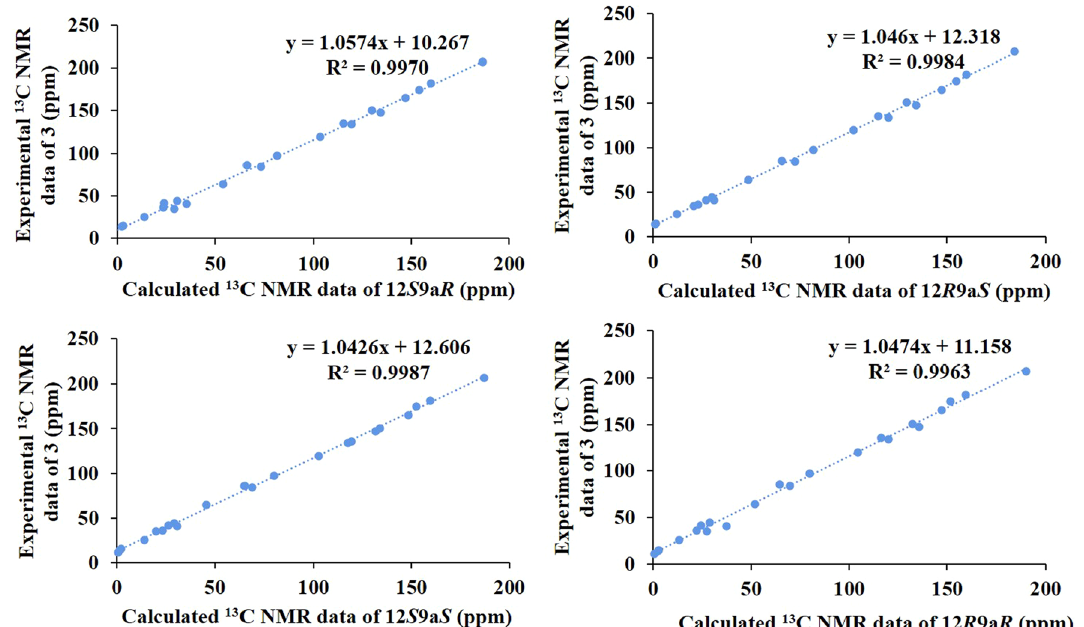
Fig. 5 Correlation plots of experimental and 13 C NMR spectral data for 3